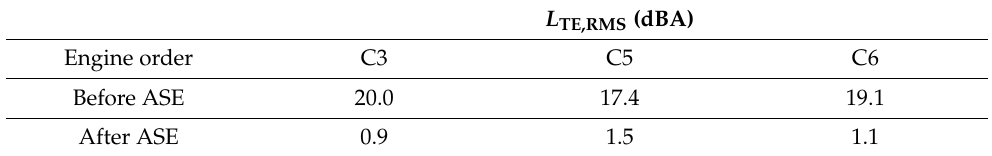
Table 1. Summary of the control performance of the proposed ASE system for the C3, C5 and C6 orders. L TE,RMS (dBA) Engine order C3 C5 C6 Before ASE 20.0 17.4 19.1 After ASE 0.9 1.5